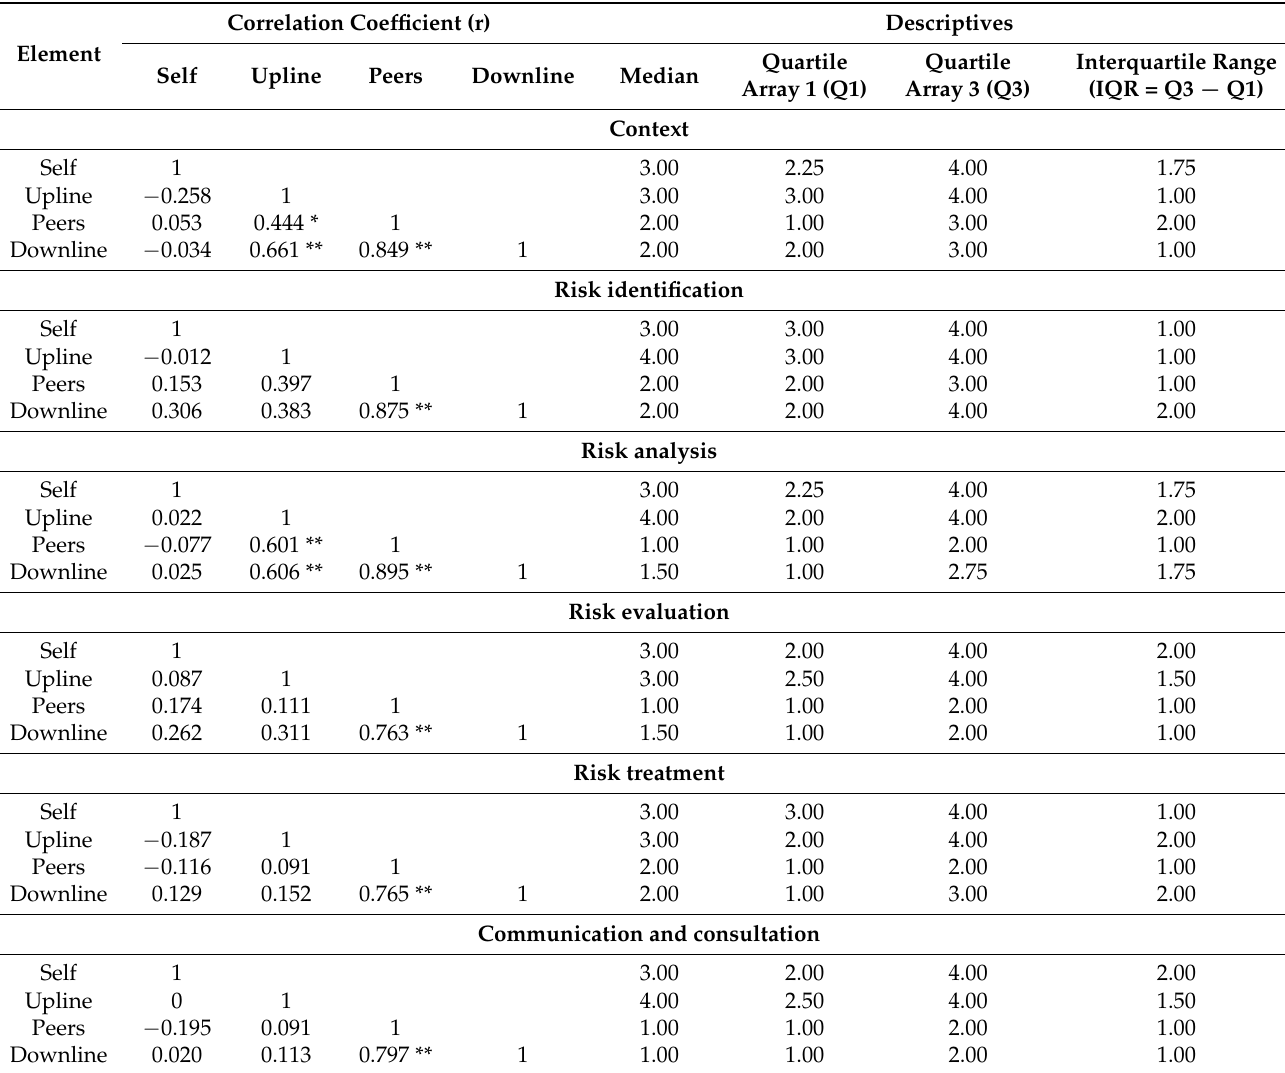
Table 1. Median and interquartile ranges and correlation coefficients of the ratings of self, and upline, peers and downline colleagues for the seven elements of the risk management